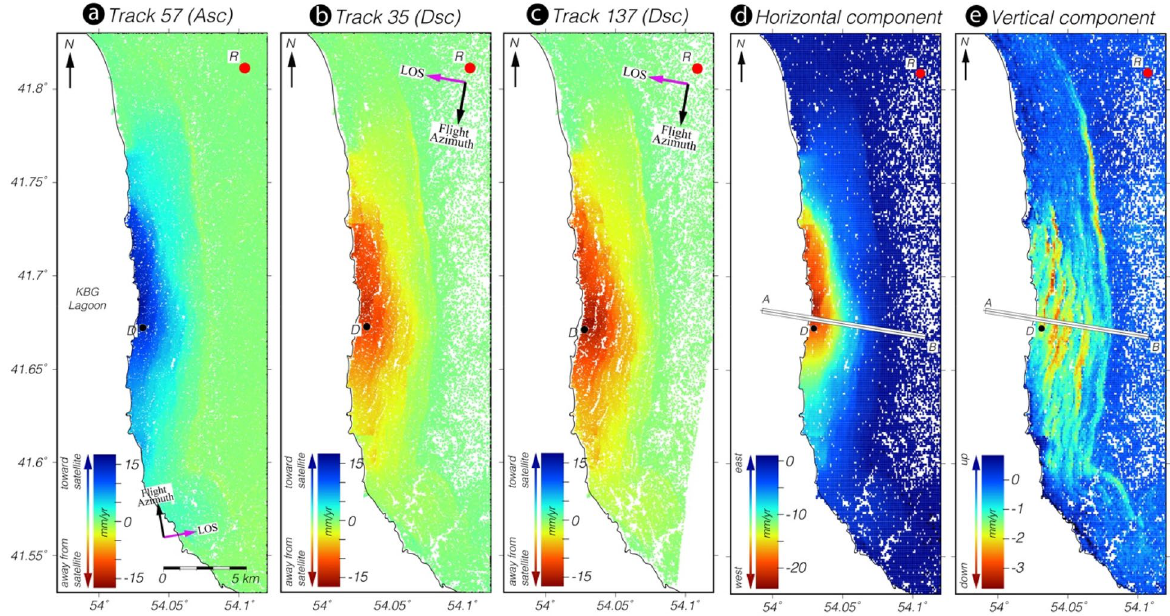
Figure 2. Mean LOS velocity fields of the KBG landslide and deformation decomposition into 2D displacement rates. Mean LOS velocity fields for the period 2014–2020, according to Sentinel 1A/B ( a ) ascending track 57 and descending tracks ( b ) 35 and ( c ) 137 obtained from the InSAR PSI time series analysis. Negative velocities (cold colors) represent ground motion toward the satellite; positive velocities (warm colors) represent motion away from the satellite. The mean velocity value of the PSI points within the solid black point (D) in ( a ), ( b ), and ( c ) is used to illustrate the temporal evolution of the landslide (Fig. 4) deformation with respect to the reference PS points within the red point (R) in the northwest region, which is considered to be a stable area. The red point (R) shows the area to which all InSAR velocities is referenced before decomposition. ( d ) Horizontal and ( e ) vertical velocity fields inverted from the LOS velocity fields of the Sentinel satellite tracks used in this study (2014–2020). Profile A–B is used to plot the vertical and horizontal velocities and elevations together with the